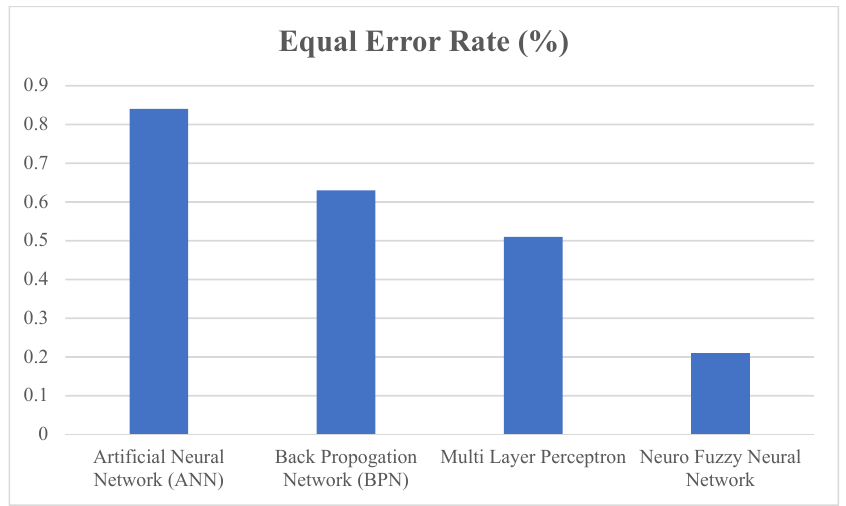
Figure 11. EER calculation for different classifiers.